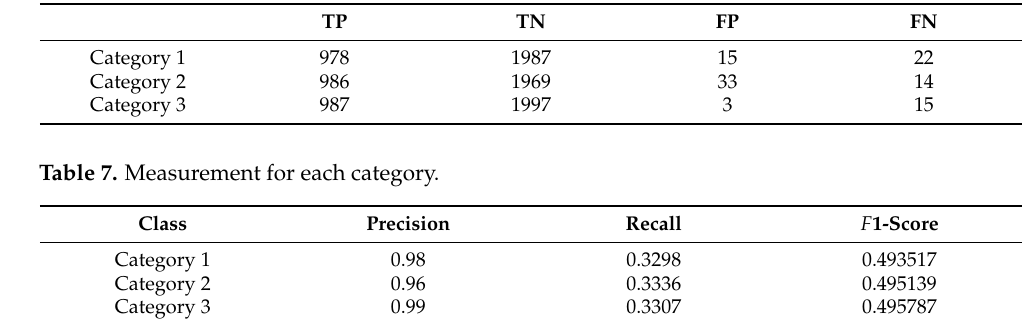
Table 6. Conversion from multiclass to binary classification confusion matrix.